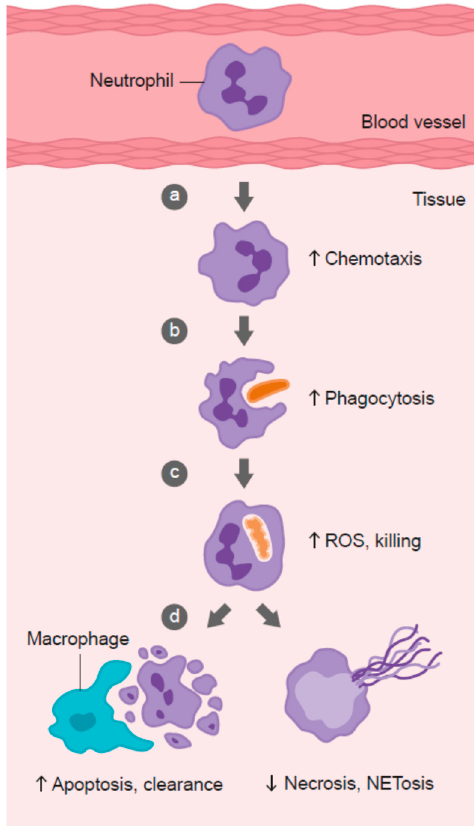
Figure 2. Role of vitamin C in phagocyte function. Vitamin C has been shown to: ( a ) enhance neutrophil migration in response to chemoattractants (chemotaxis), ( b ) enhance engulfment (phagocytosis) of microbes, and ( c ) stimulate reactive oxygen species (ROS) generation and killing of microbes. ( d ) Vitamin C supports caspase-dependent apoptosis, enhancing uptake and clearance by macrophages, and inhibits necrosis, including NETosis, thus supporting resolution of the inflammatory response and attenuating tissue damage.